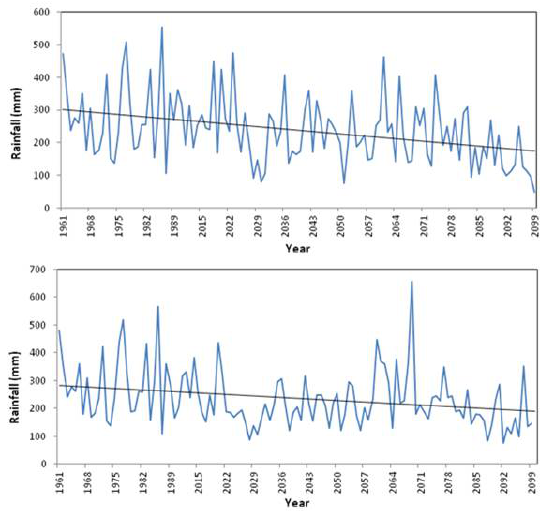
Figure 9. Future monthly average rainfall for different time slices for A2 scenario (upper) and B2 scenario (lower) compared with control period.